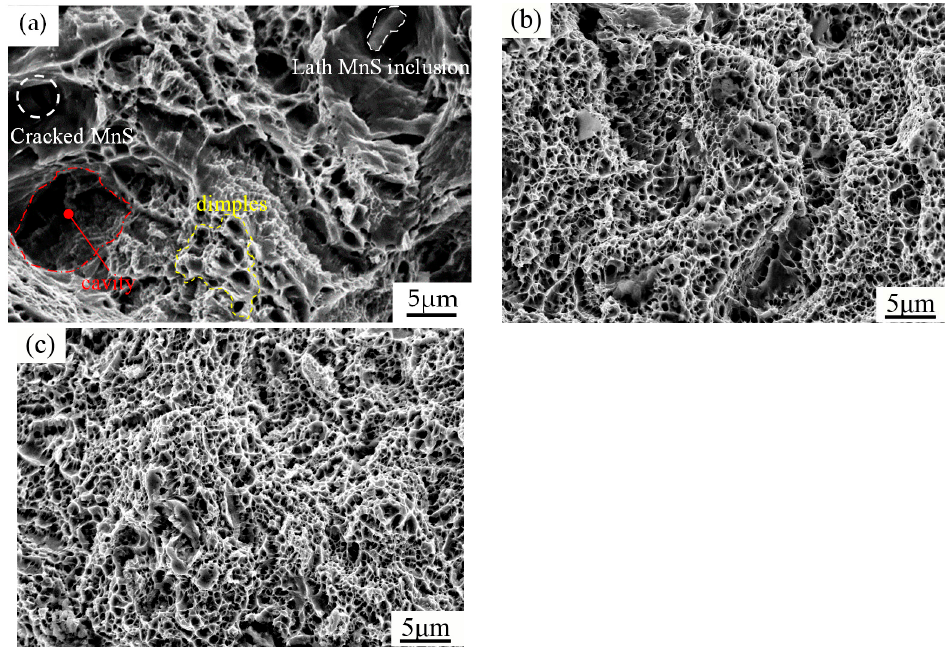
Figure 5. SEM micrographs of tensile fracture surfaces of different casing drilling steels; ( a ) dimples and caves on the fracture surface of K55 specimen; ( b ) dimples on the fracture surface of N80 specimen; ( c ) dimples on the fracture surface of P110 specimen.